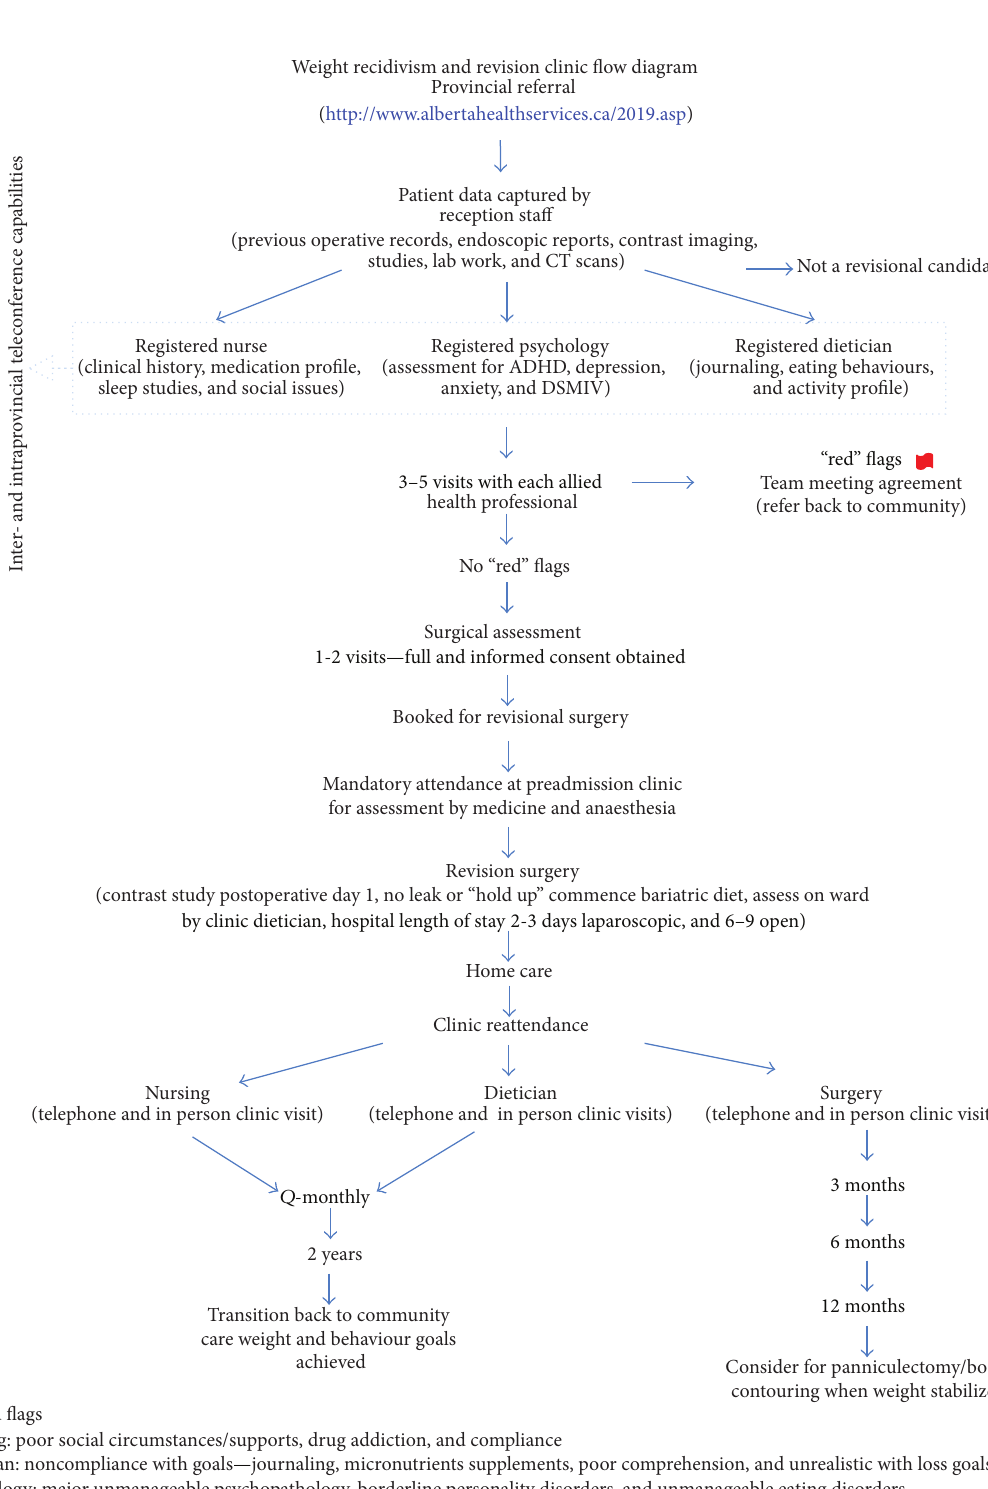
Figure 1: Multidisciplinary clinic flow